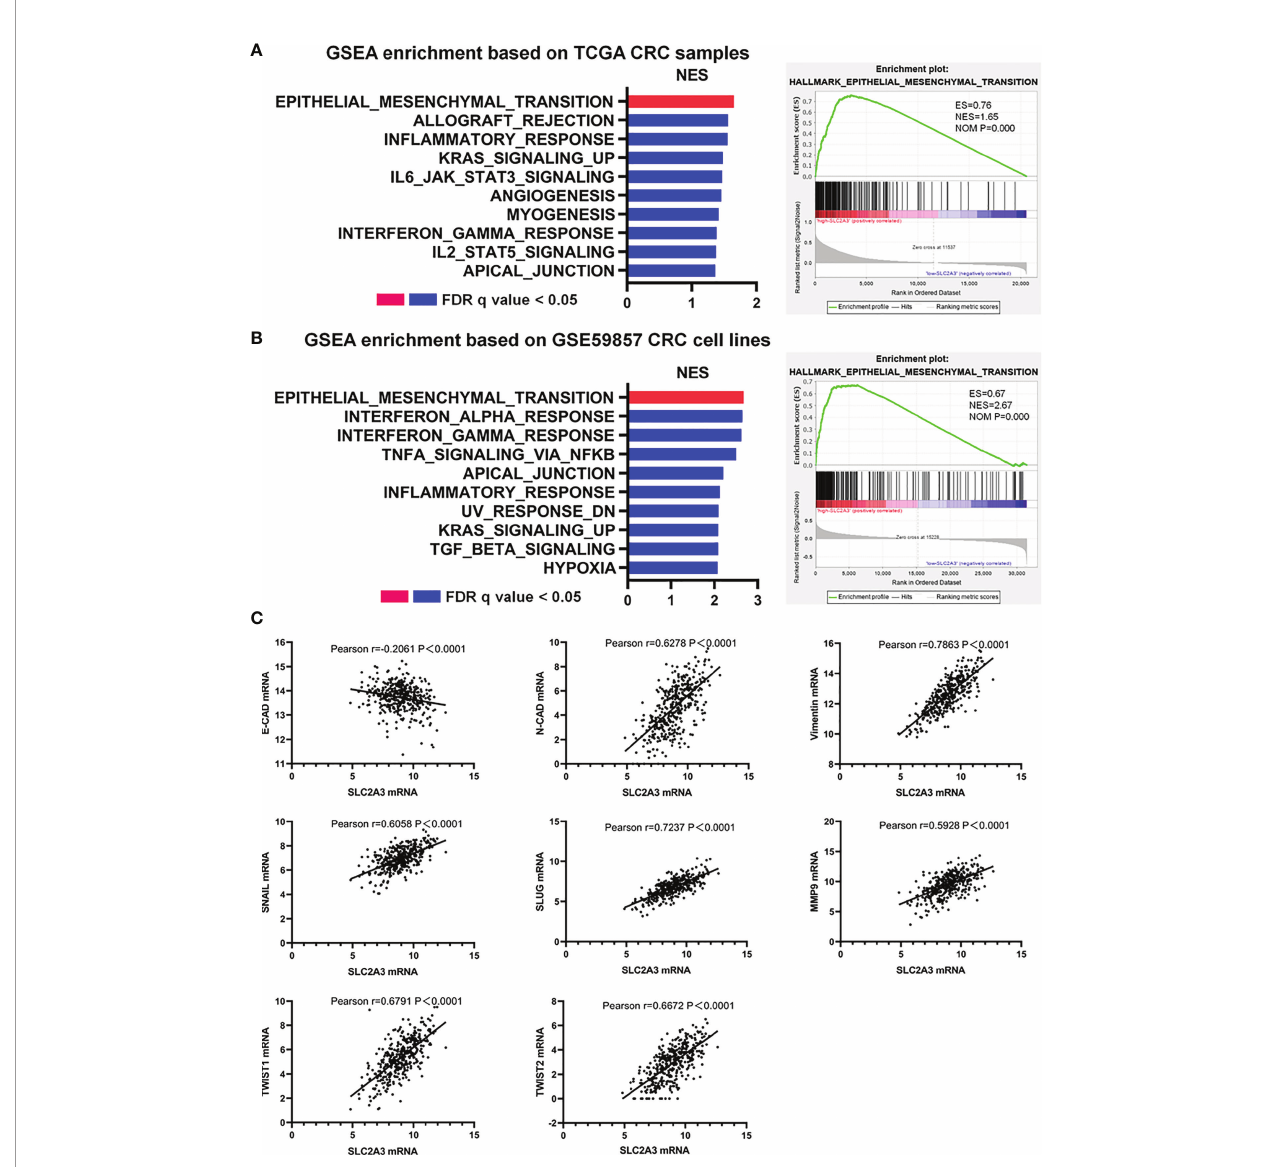
FIGURE 3 | SLC2A3 expression correlated with EMT signatures in CRC. (A) GSEA enrichment based on TCGA CRC samples, (B) GSEA enrichment based on GSE59857 CRC cell lines, and (C) TCGA database showed SLC2A3 expression was positively correlated with N-CAD, Vimentin, SNAIL, SLUG, MMP9, TWIST1, and TWIST2 expression, negatively correlated with E-CAD expression. All gene sets were signi fi cantly enriched at nominal p value <0.05 and FDR q value <0.05. NES, normalized enrichment score. FDR, false discovery